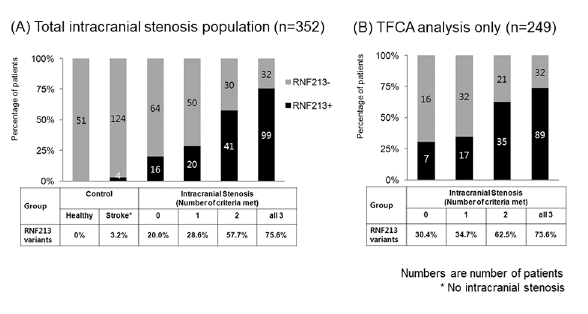
Fig 1. Number of cases with RNF213 variant+ among intracranial patients with healthy and stroke